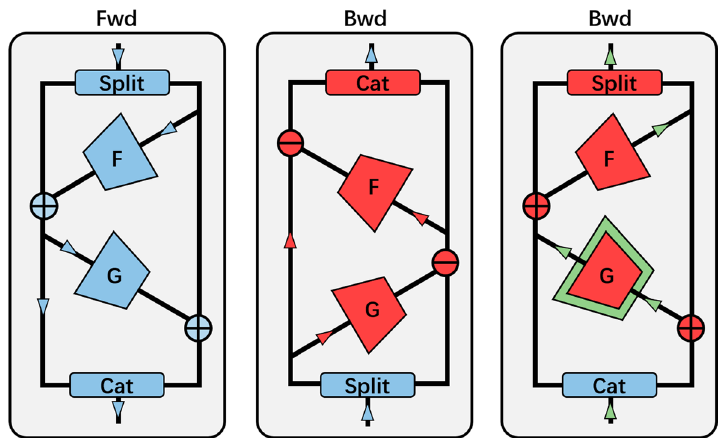
Fig. 2 Illustration of the backpropagation process through a reversible block. In the forward pass (left), activations are propagated forward from top to bottom. The activations are not kept in live memory as they are to be recomputed in the backward pass so no memory bottleneck occurs. The backward pass is made of two phases: first the hidden and input activations are recomputed from the output through an additional forward pass through both modules (middle). Once the activations recomputed, the activations gradient are propagated backward through both modules of the reversible blocks (right). Because the activation and gradient computations flow in opposite directions through both modules, both computations cannot be efficiently overlapped, which results in the local memory bottleneck of storing all hidden activations within